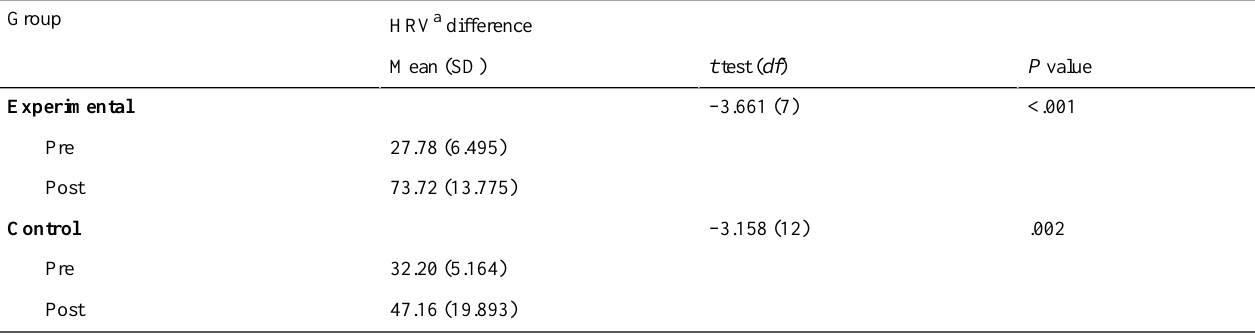
Table 4. Paired t test for experimental and control group heart rate variability score